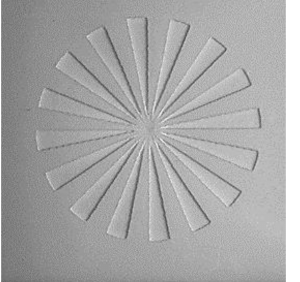
Figure 2. Inhomogeneous optical conditions in the ROI (e.g. shad- ows, low contrast) (Heinl et al.,